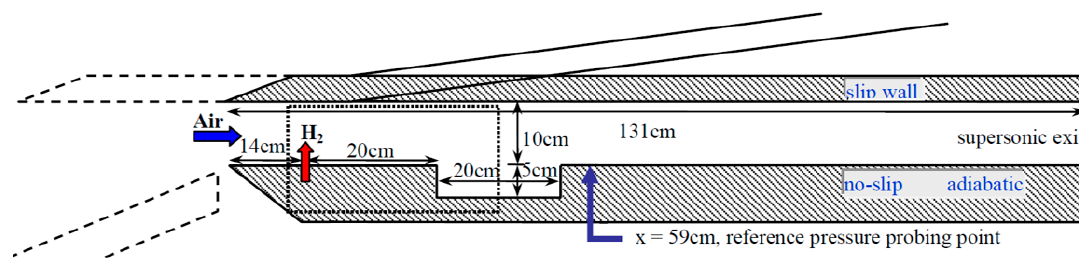
Figure 1. Configuration of a scramjet engine from previous numerical experiment performed by Choi Figure 1. et al. [1]